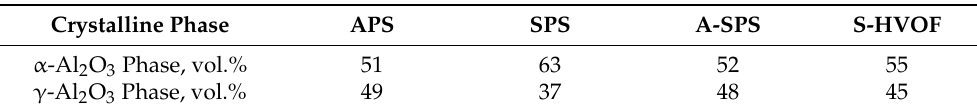
Table 3. Quantitative estimation of the XRD phase composition (based on Equation (1)) in coatings sprayed using different